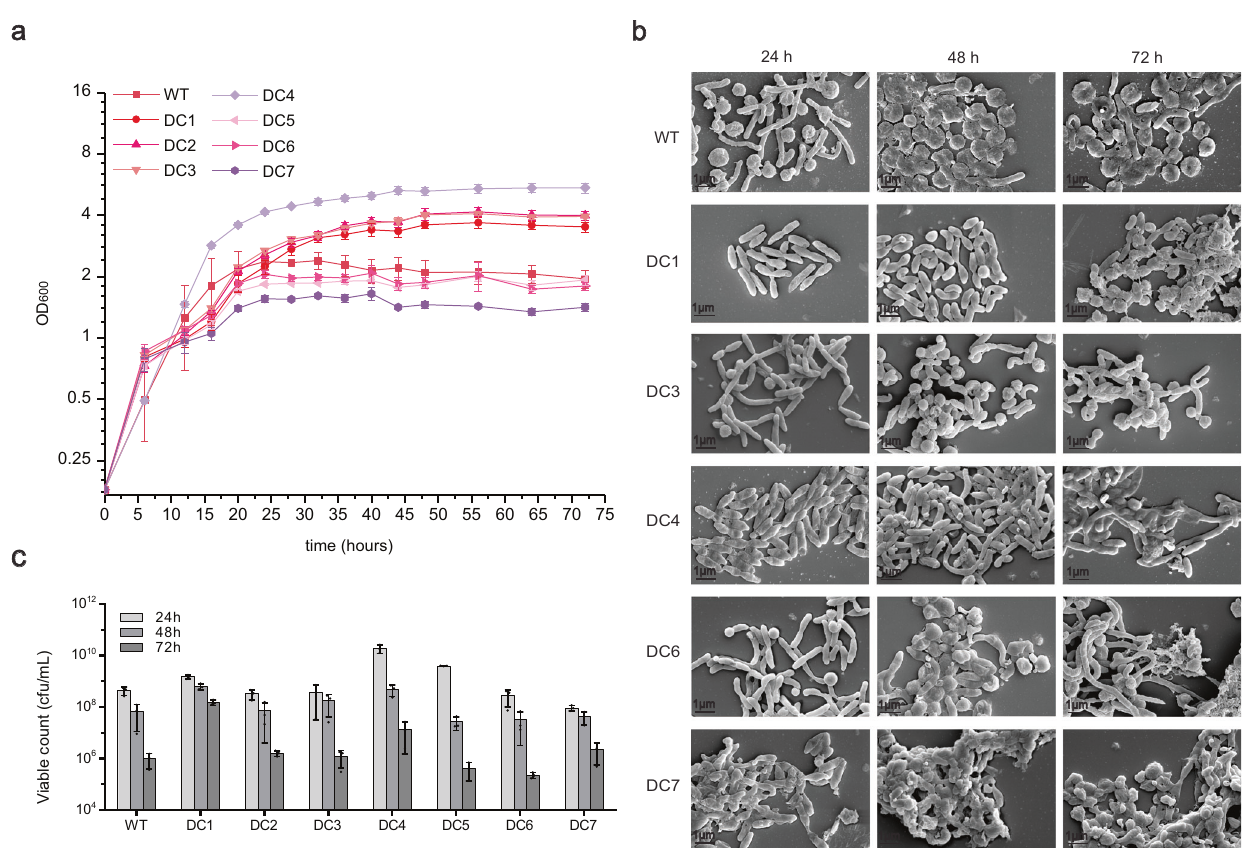
Fig. 2 Characterization of the DC series genome-reduced mutants. a The growth pro fi les of the DSM 7029 wild type (WT) and the genome-reduced mutants DC1 to DC7 were measured by culturing in CYMG normal medium after uniform starting OD 600 values. Data are presented as mean values ± SD. n = 3 biologically independent samples. b Cell morphology determination by using the fi eld emission scanning electron microscopy (FESEM) of the WT, DC1, DC3, DC4, DC6, and DC7, at 24 h, 48 h, and 72 h, respectively. The experiment was repeated twice independently with similar results. c The viable counts of the DSM 7029 and DC1 to DC7 at 24 h, 48 h, and 72 h, respectively. Data are presented as mean values± SD. n = 3 biologically independent samples. cfu, colony-forming number. Source data underlying ( a , c ), are provided as a Source Data fi